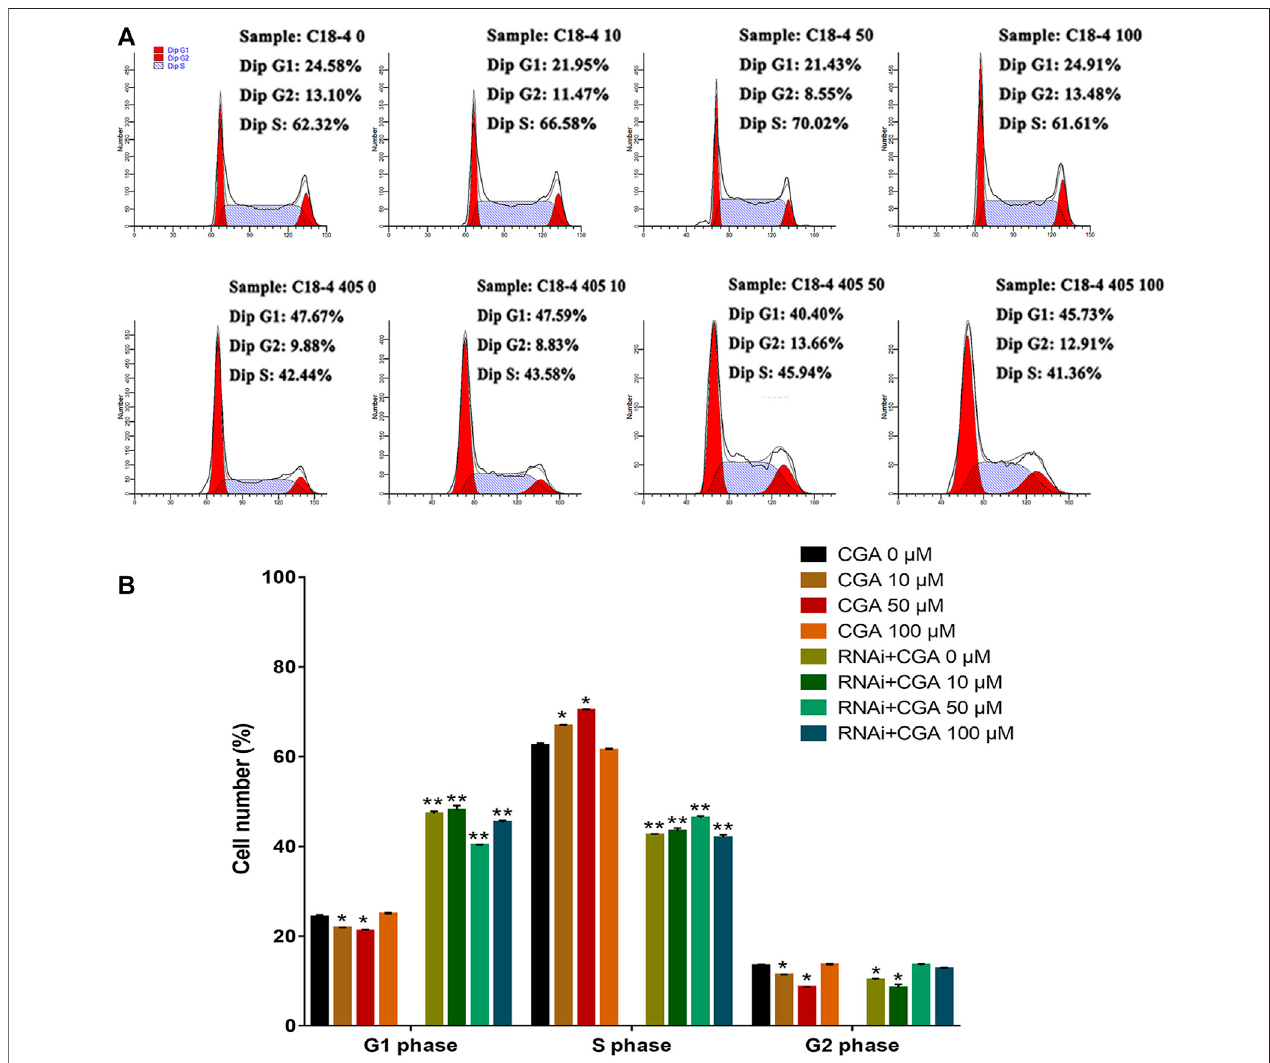
FIGURE 4 | The effect of CGA on SSCs proliferation. C18-4 cells and Shp2 knockdown C18-4 cells (RNAi) were cultured with CGA (10, 50, and 100 μ M) for 36 h, and the cell cycle was determined using FACS. (A) FACS analysis of the cell cycle. (B) The results of statistical analyses. Values are expressed as the mean ± SD ( n = 3) * p < 0.05, ** p < 0.01 vs CGA 0 μ